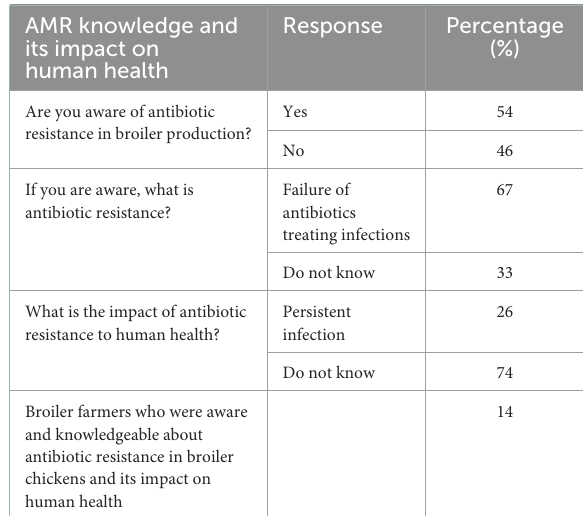
TABLE 4 Knowledge of antibiotic resistance and its impact on human health ( N =